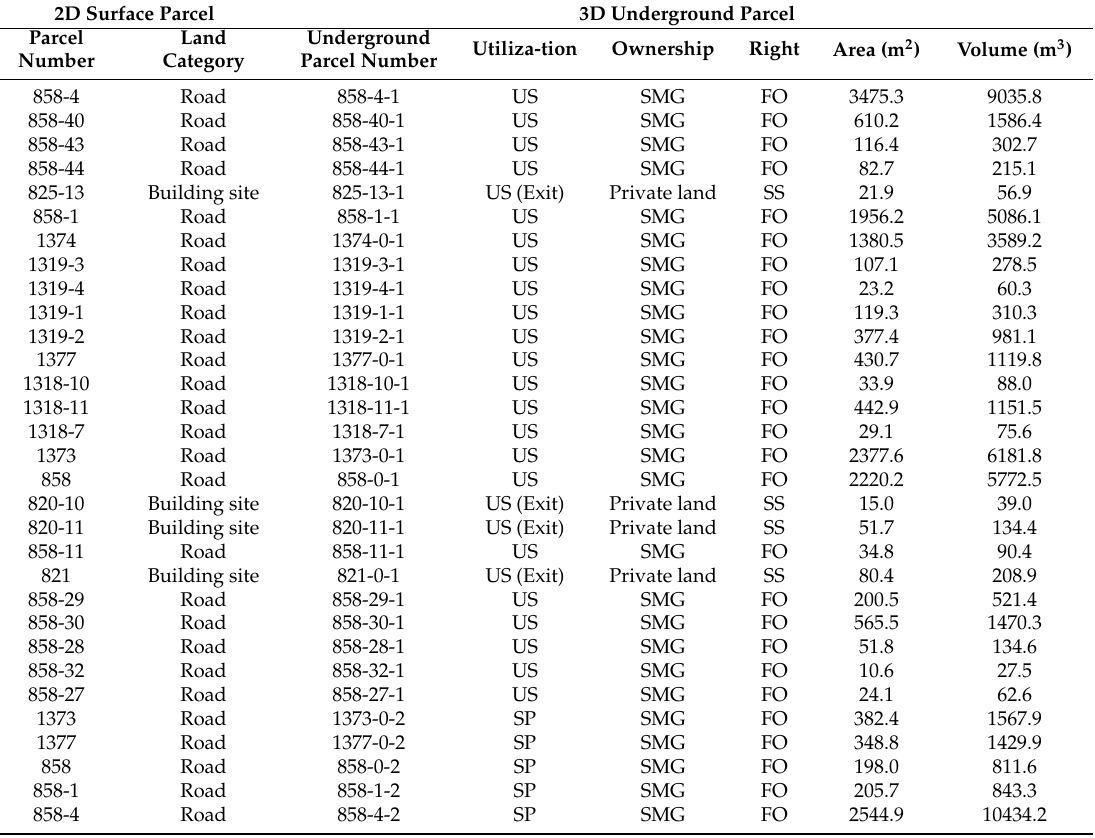
Table 4. Relationship between 2D surface parcel and 3D underground